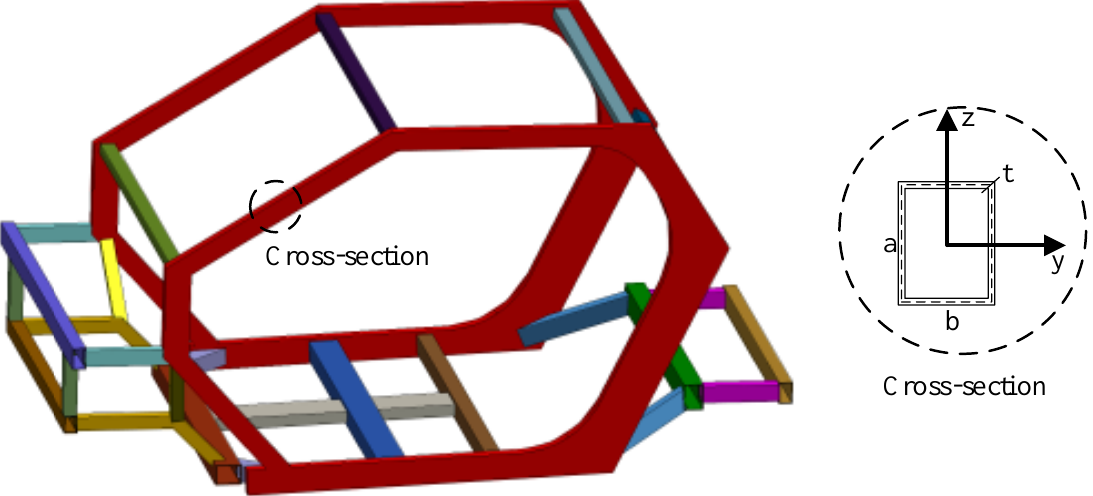
Figure 1. The conceptual BIW model.